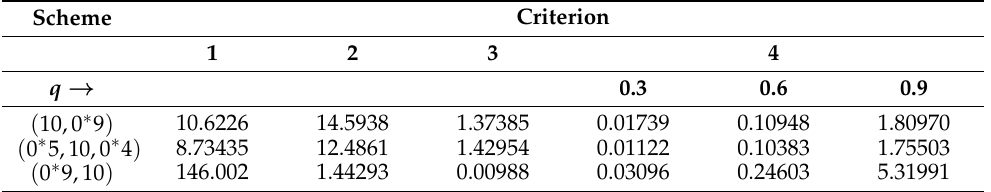
Table 8. Optimal progressive censoring from electrical appliances data.